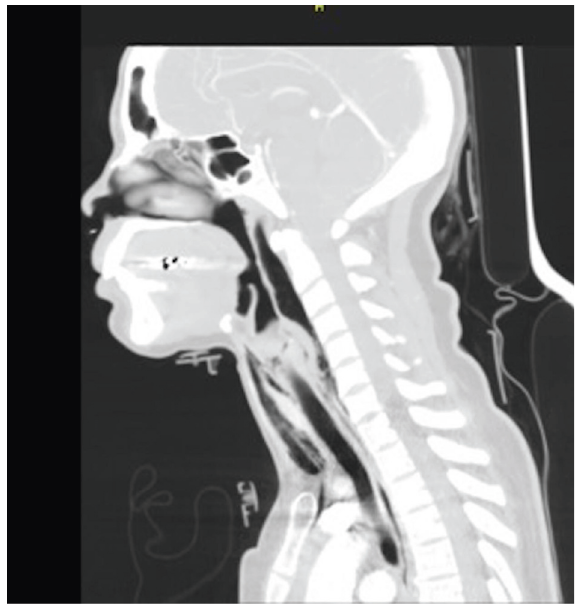
Figure 3: Subcutaneous emphysema is observed dissecting the visceral, carotid, and prevertebral space and causing anterior and middle pneumomediastinum, with a decrease in the diameter of the airway at the level of the